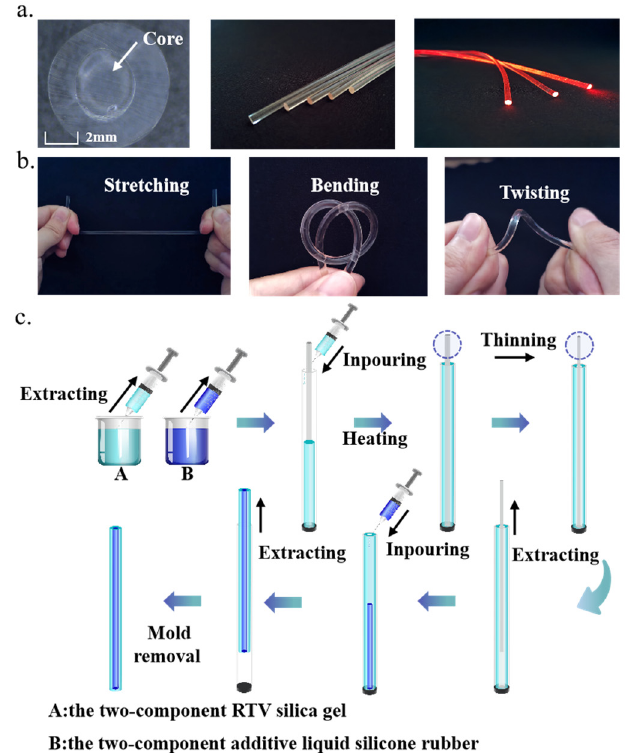
Figure 2. ( a ) The cross-section of flexible optical fiber. ( b ) The state of flexible optical fiber under tension, bending and torsion. ( c ) Manufacturing process of flexible optical fiber.